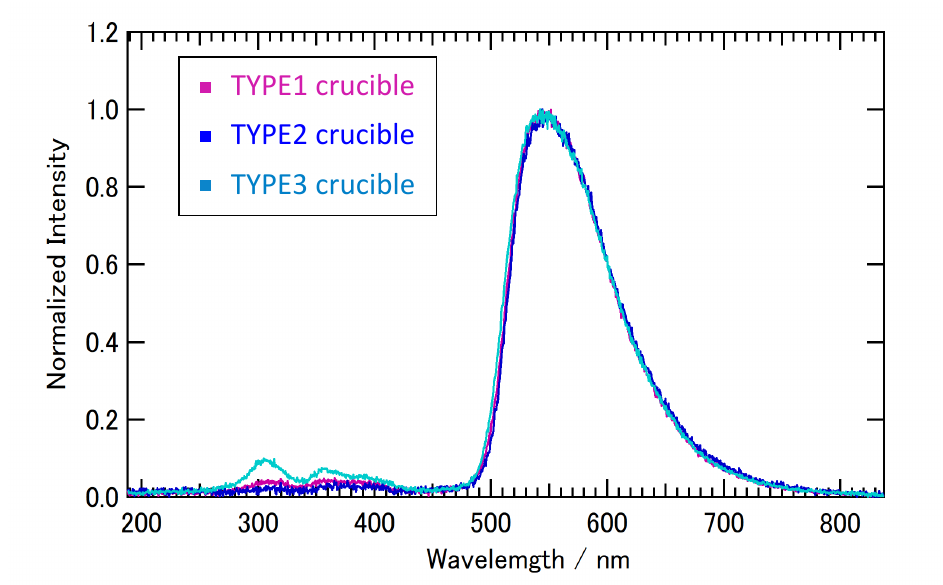
Figure 9. Radioluminescence spectra of grown crystals. All sample shapes were the same with a broad-band emission and peak at 540 nm, which is typical for Ce 3 + 5d-4f emission in YAG crystals. The small and broad emission around 250–400 nm is ascribed to self-trapped exciton and YAl anti-site